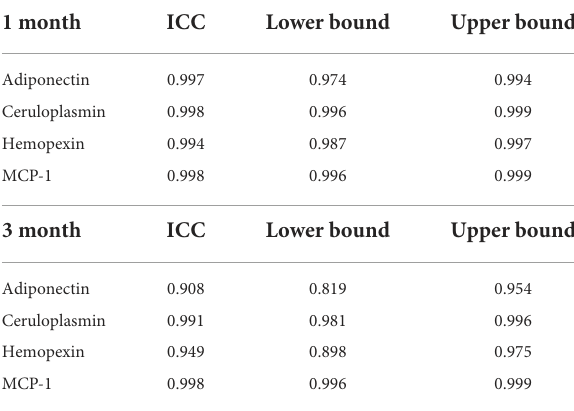
TABLE 3 ICC values at 1- and 3-months of